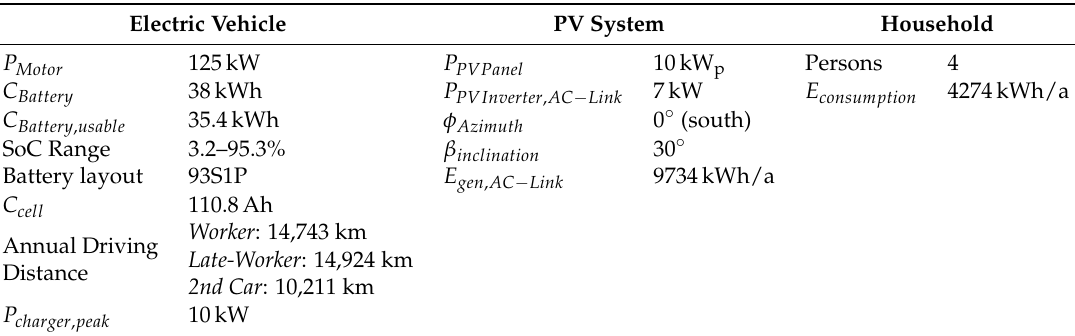
Figure 4. Schematic of the simulation model. The solid lines show the power flow and the dashed lines show the information flow. The main information systems are the Energy Management System (EMS) and Battery Management System (BMS). Table 1. Summary of the characteristics of the EV, the PV system, and the household